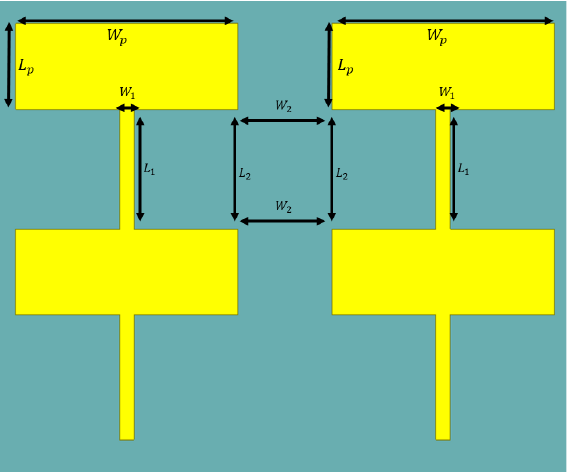
Figure 6. A structure in which two sets of initially designed antennas are stacked together.